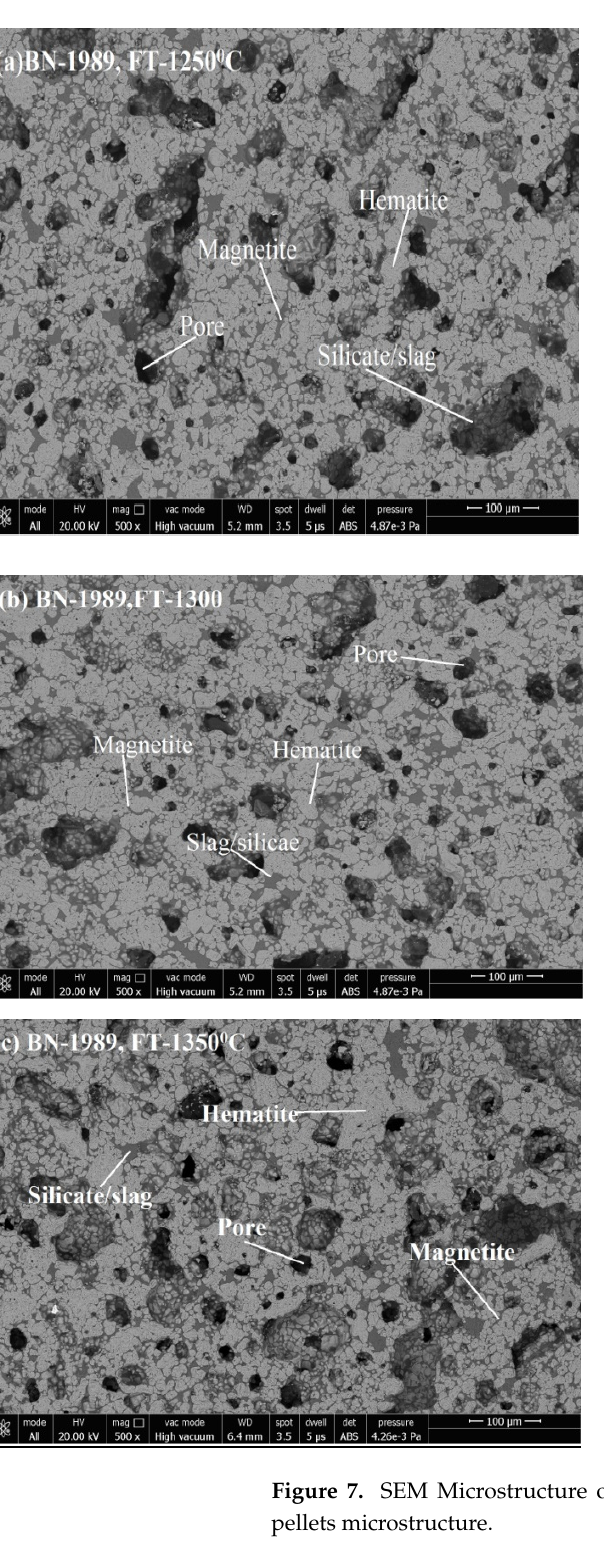
Figure 6. SEM Microstructure of ( a ) K3A, ( b ) K3B, ( c ) K3C, ( d ) K4A, ( e ) K4B, and ( f ) K4C pellets.